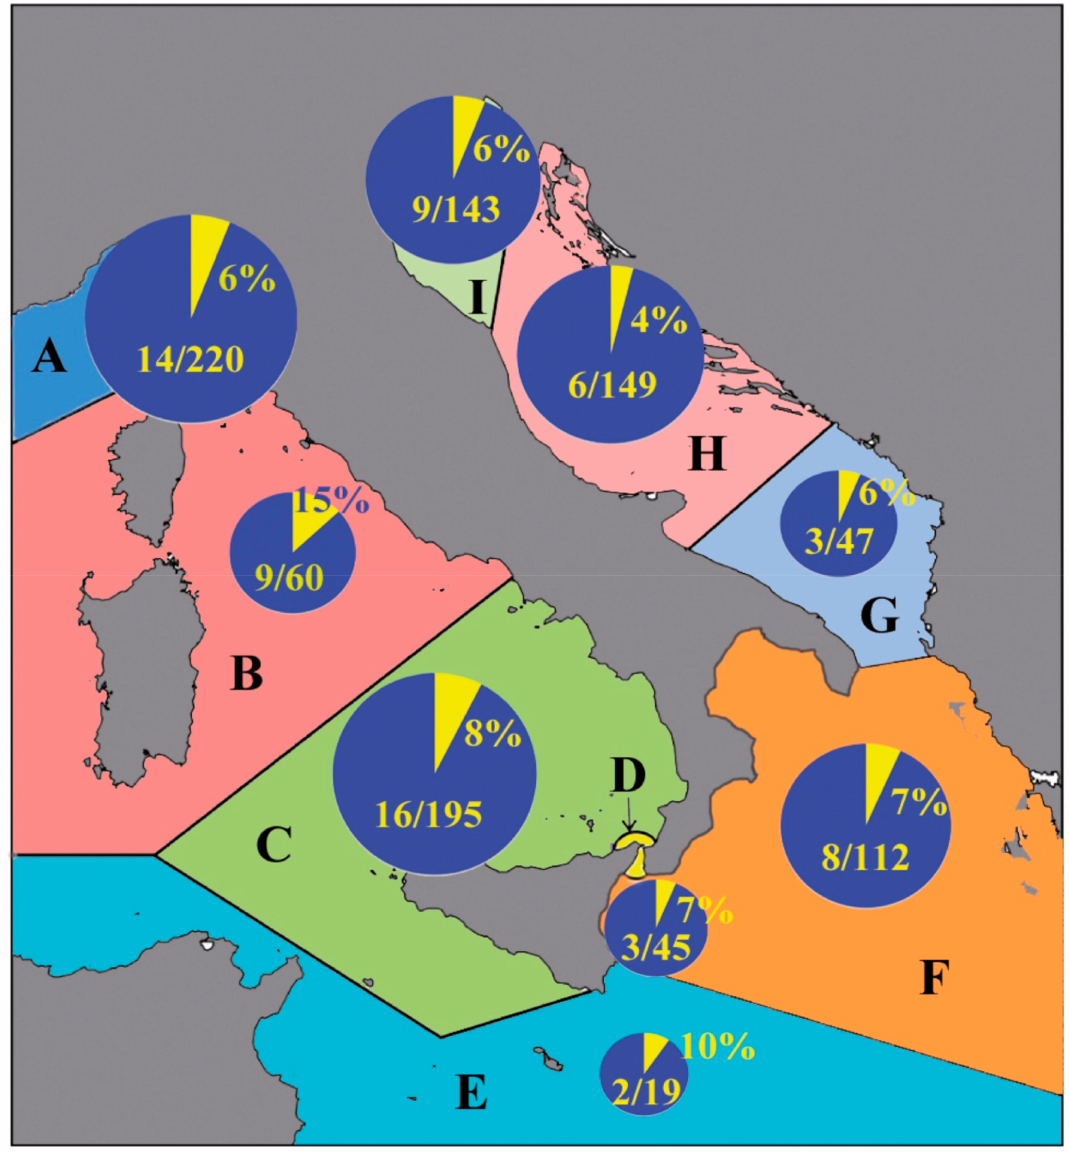
Figure 4. Distribution of CC NIS in each biogeographic area within the Italian Seas following Bianchi [93]. ( A ) Ligurian Sea; ( B ) central Tyrrhenian Sea; ( C ) south Tyrrhenian Sea; ( D ) Strait of Messina; ( E ) south-eastern tip of Sicily, Pelagie Islands; ( F ) Ionian Sea; ( G ) south Adriatic Sea; ( H ) central Adriatic Sea; ( I ) north Adriatic Sea. For each sector, CC NIS percentage and CC NIS number/Cnidaria and Ctenophora total number are